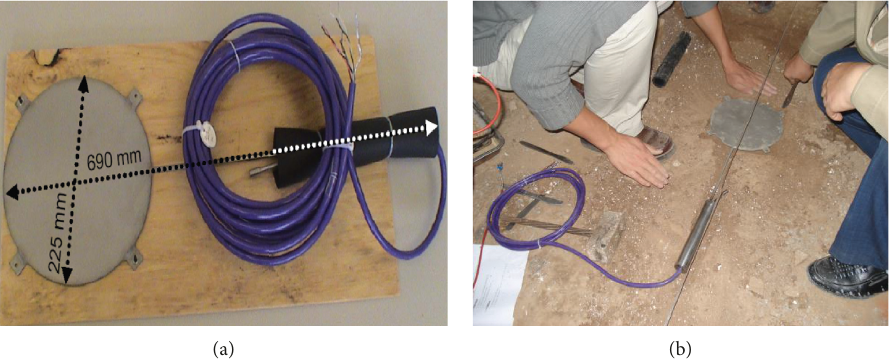
Figure 9: Pressure cell model Geokon-3500: (a) photograph of Geokon-3500; (b) Geokon-3500